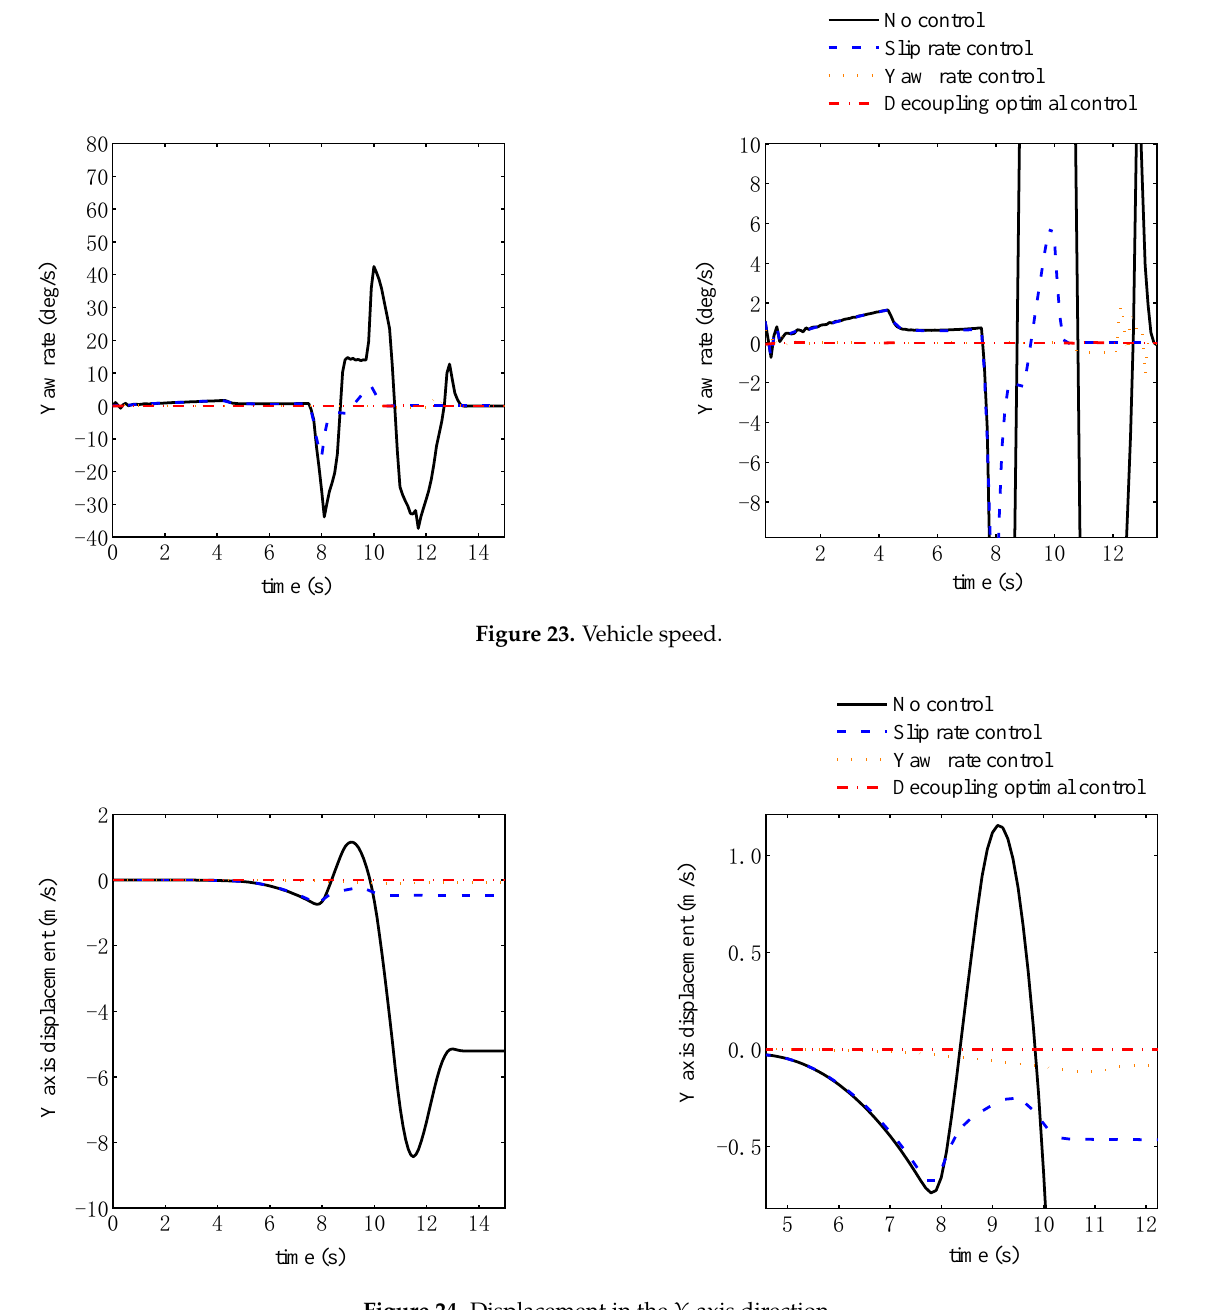
Figure 24. Displacement in the Y -axis direction.